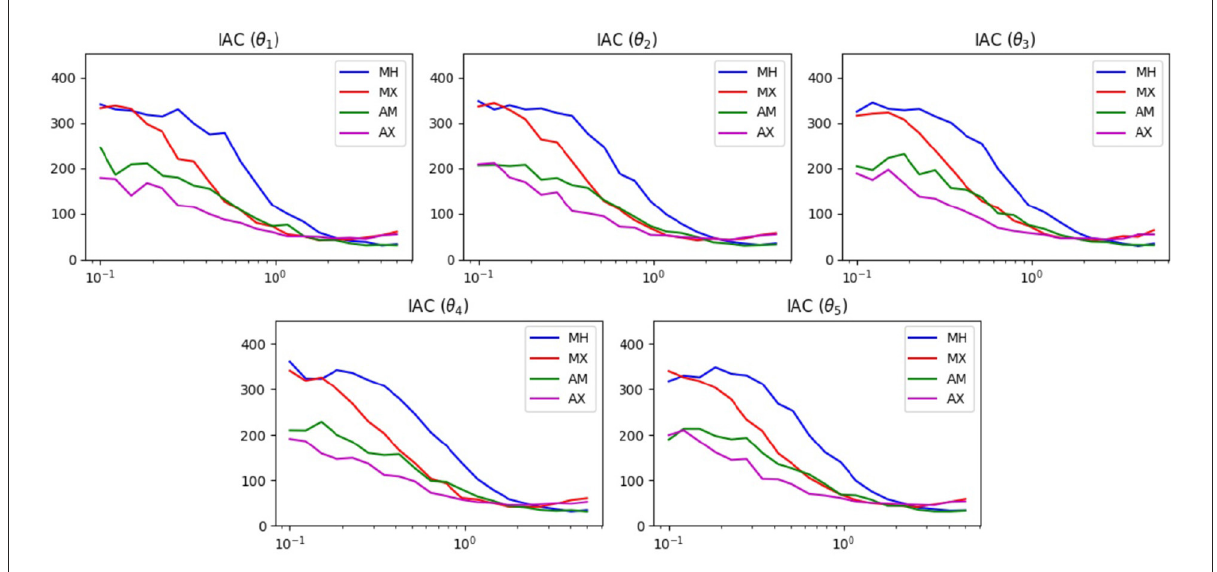
FIGURE4 IAC results of MCMC test on the 5D Ackley function. The horizontal axis displays the proposal width (logarithmic scale). The vertical axis is the average lower bound of the IAC.